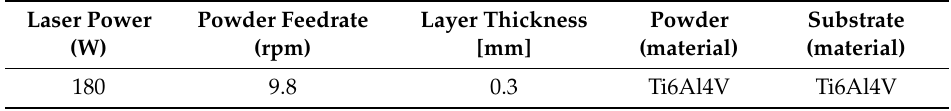
Figure 3. The morphology ( a ) and microstructure ( b ) of the Ti6Al4V powder used for manufacturing of honeycomb structures by the laser engineered net shaping (LENS TM ) technique. Table 2. Basic parameters used for manufacturing honeycomb structures by the LENS